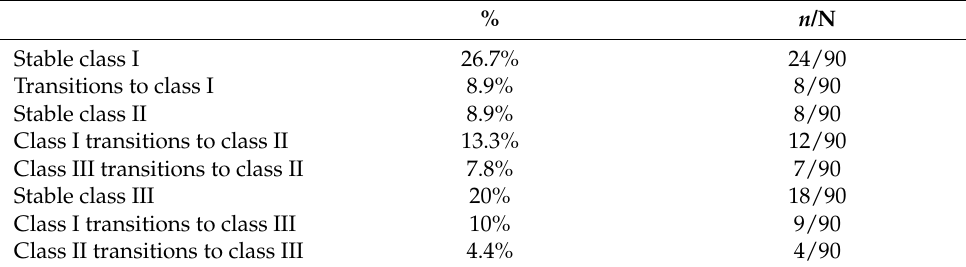
Table 3. Transition in the effectiveness endpoint for ITT patients during the study based on the Raymond–Roy